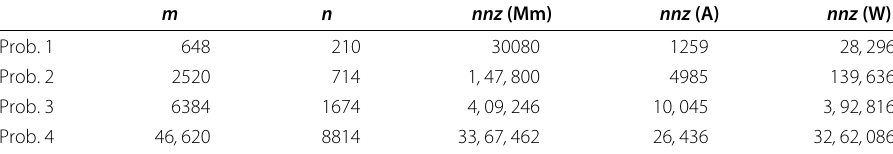
Fig. 2 Saddle point system for cylinder, Problem 1 Table1 Definition of the cylinder test problems Prob. 1 to Prob. 4